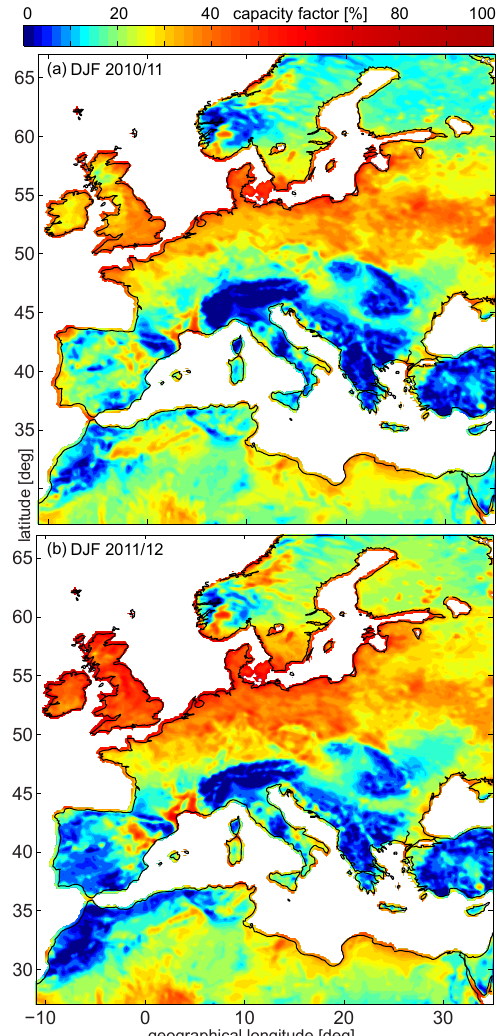
Fig. 2. Mean capacity factor from ECMWF 100m wind and exemplary power curve for winter (DJF) of (a) 2010/2011 and (b) 2011/2012 using a logarithmic color scale.